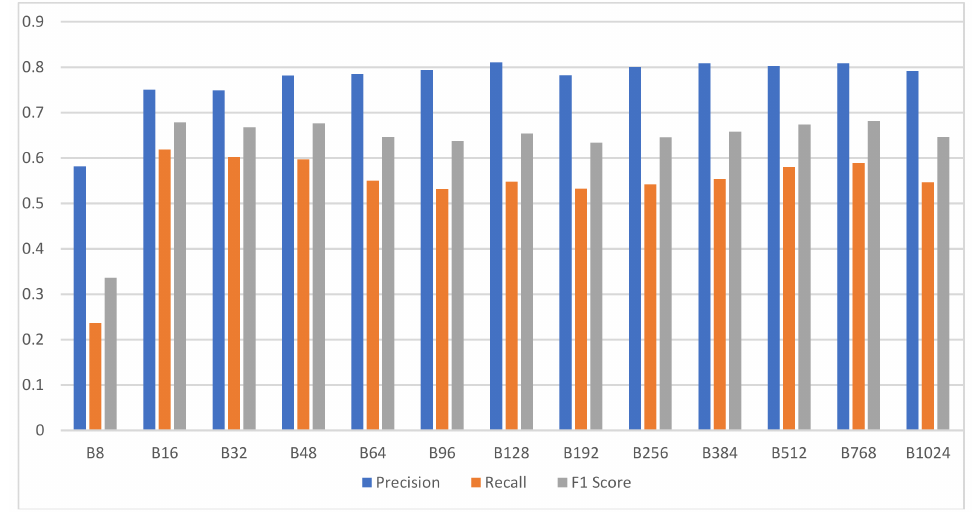
Figure 10. Classification performance of Wave2vec by encoding resolution. X-axis represents the encoding base numbers and y-axis represents the score, whose scale is from 0 to